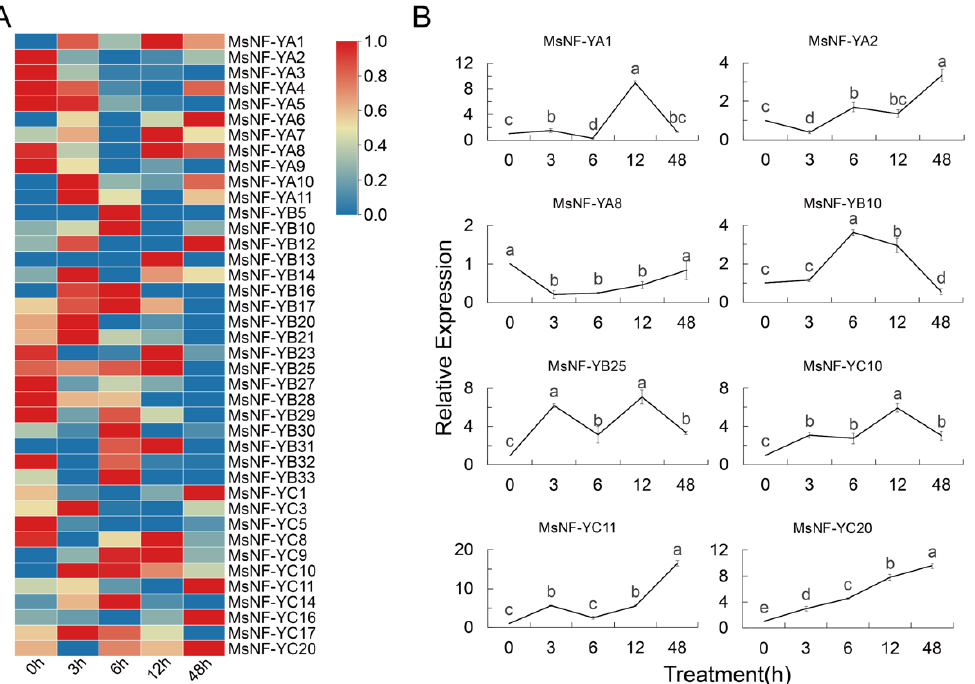
Figure 5. Heatmap of ( A ) RNA-seq data for the MsNF-Y gene family and expression profiles of 8 MsNF-Y genes. ( B ) Under alkali treatment by qPCR: alfalfa seeding in response to 150 mM NaHCO 3 . Data are means ± SE of three replicates. Different lowercase letters indicate significant differences ( p < 0.05).